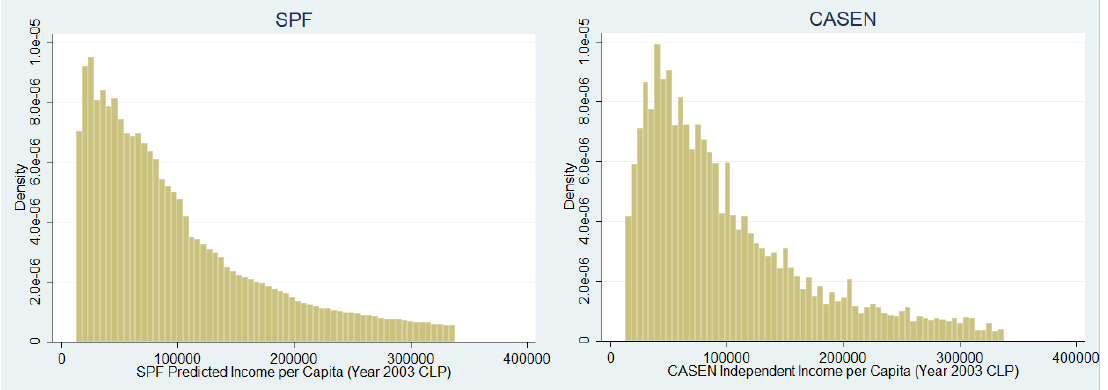
Figure 6: Income per Capita Distribution (SPF Prediction and